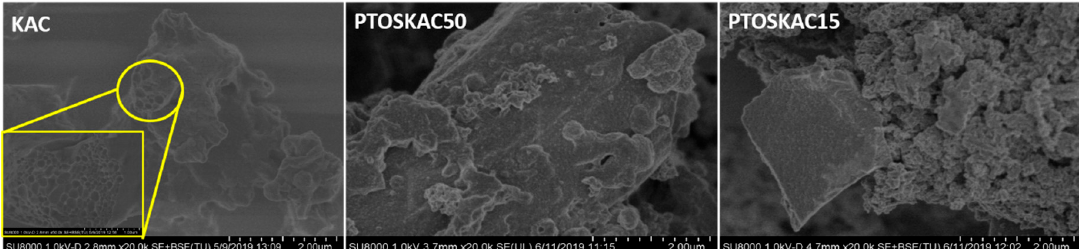
Figure 2. SEM micrographs of KAC and PEDOT-KAC composite materials. Micrographs correspond to 20k× magnification and the enlargement of the yellow boxed area corresponds to 50k× magnification. Table 2. Surface area, pore volume and average pore size of commercial activated carbon (CAC) and